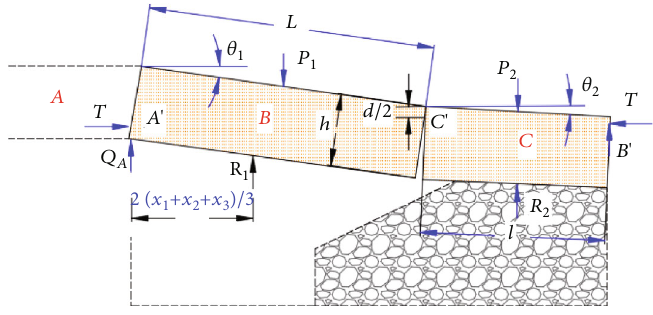
Figure 7: Stress state of key blocks B and C. Table 1: Physical mechanical parameters of coal rock in the established